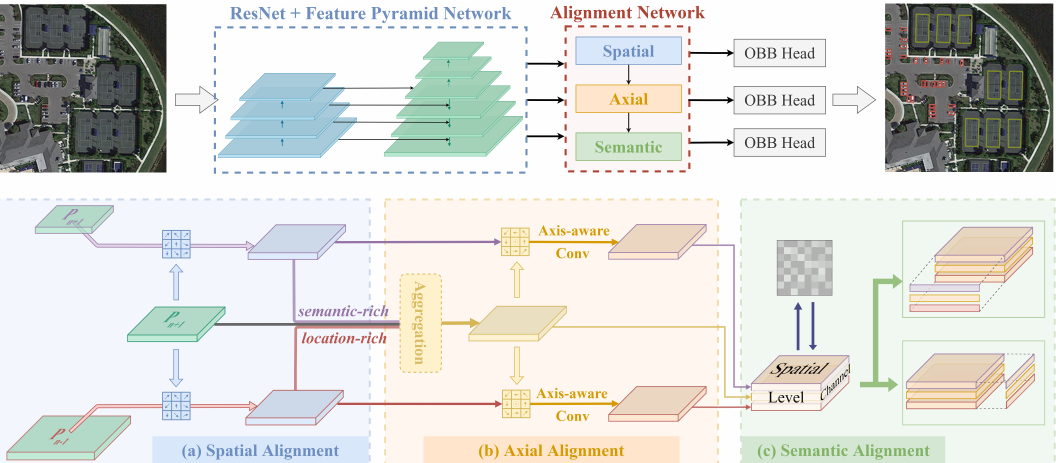
Figure 2. The overall architecture of our OA-Det for oriented object detection consists of a backbone network, a feature alignment network, and an anchor-free head network. The ResNet-based feature pyramid network extracts common features from an RGB aerial image. The feature alignment network sequentially aligns pyramid features from three dimensions: ( a ) an intra-level collaborative alignment network in the spatial dimension, ( b ) an axis-aware convolution in the axial dimension, and ( c ) a hierarchical-wise context fusion module in the semantic dimension. Finally, aligned features are sent to the classification head and the regression head to obtain the OBB prediction